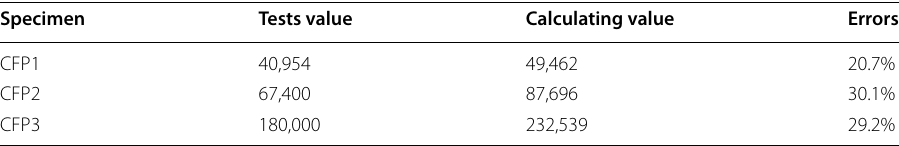
Table 2 Predicted value of corrosion fatigue life